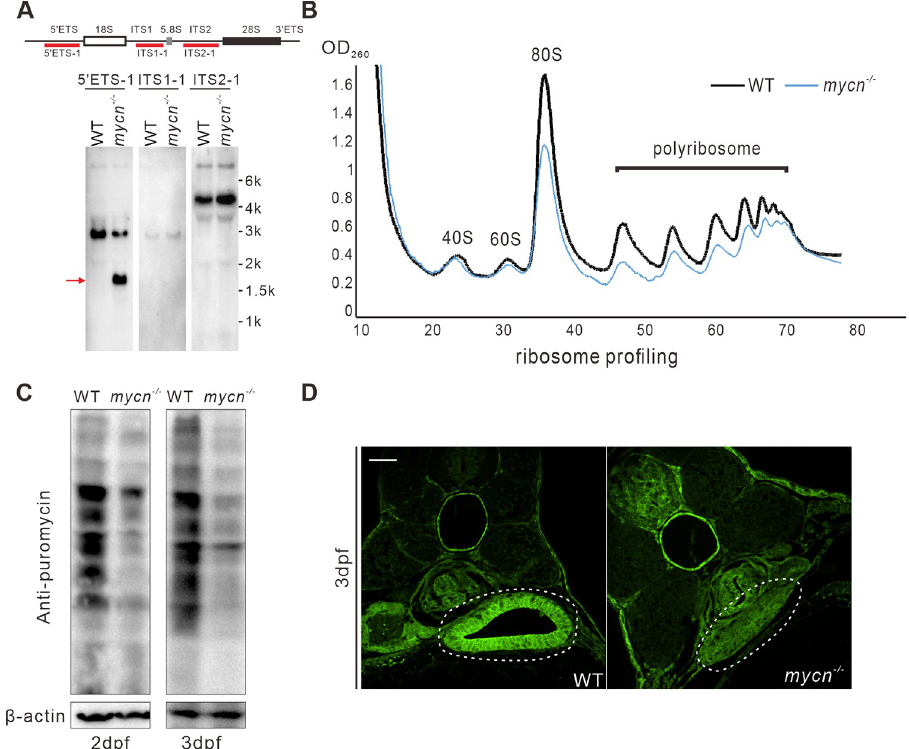
Fig 6. Abnormal rRNA processing and impaired protein translation in mycn mutants. (A) Northern blot analysis of mycn mutant and WT embryos at 5 dpf was performed using probe 5 0 ETS1, ITS1-1, and ITS2-1. Schematic drawing showing the structure of the pre-rRNA and probe positions of zebrafish (top) [34]. All samples were normalized by the total RNA. (B) Ribosomal profiling of mycn mutant and WT embryos at 3 dpf was performed by sucrose density– gradient centrifugation. All samples were normalized by the total RNA. (C) Detection of nascent protein synthesis by puromycin incorporation assay in WT and mycn mutant embryos at 2 and 3 dpf. Puromycin-incorporated neosynthesized proteins were detected by western blot with anti-puromycin antibody. The β -actin expression level was used as internal control. (D) Nascent protein synthesis was detected by section immunofluorescence with anti- puromycin antibody in WT and mycn mutant embryos at 3 dpf. Sections were cut along the transverse plane. All embryos are shown in dorsal view. Scale bar: 50 μ m ( C ), 200 μ m ( D - F ). Raw images of this figure are provided in S1 Raw Images. dpf, days postfertilization; WT,